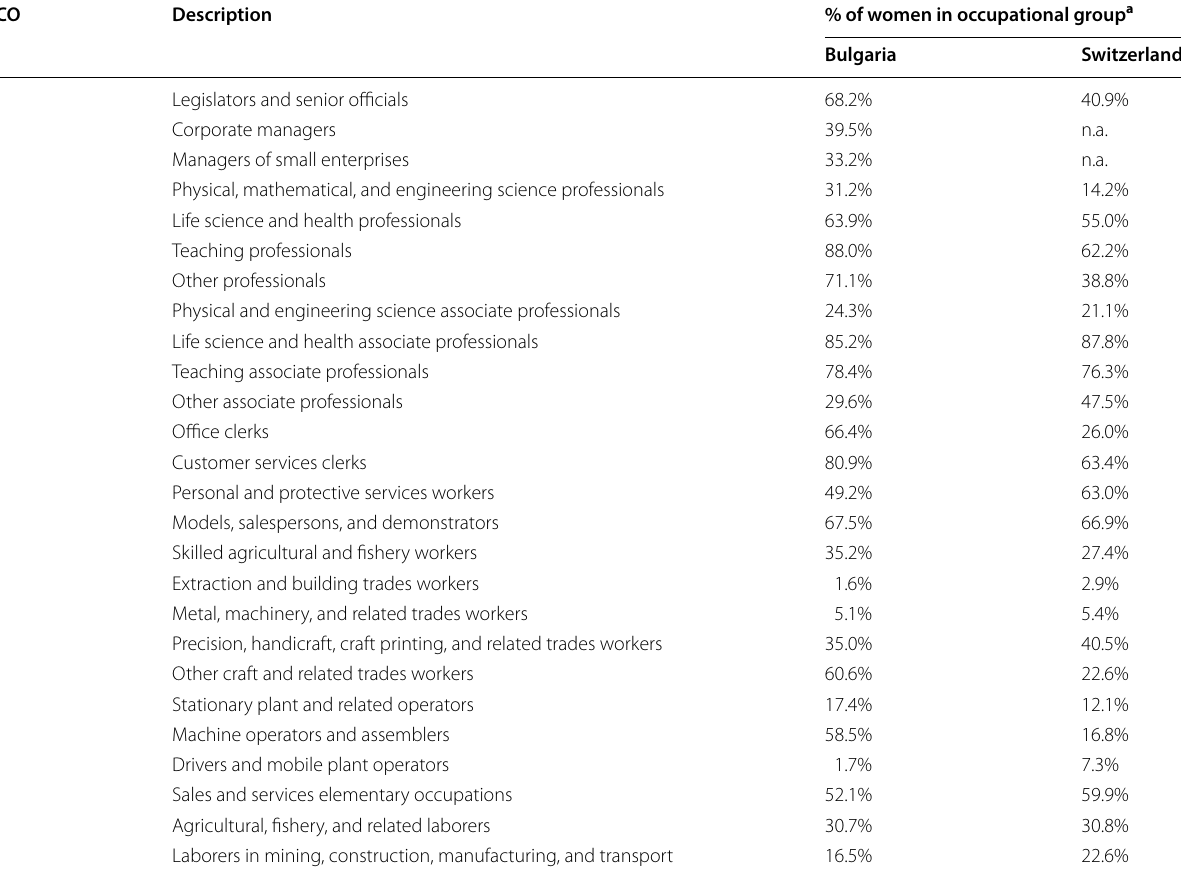
Table 13 Classification of occupational groups (ISCO88 2-digit) and share of women per occupational group in Bulgaria and Switzerland